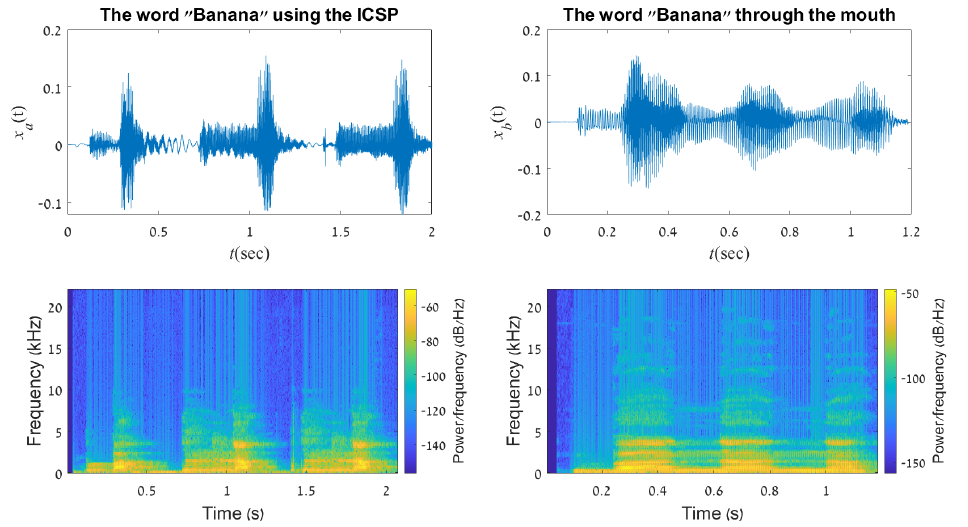
Figure 6. A representation of the word “Banana” created using the ICSP ( left graph ) and the human mouth ( right graph ). Top graphs represents the audio signals in the time domain. Down graphs are the frequency spectrum of the audio signals as it varies with